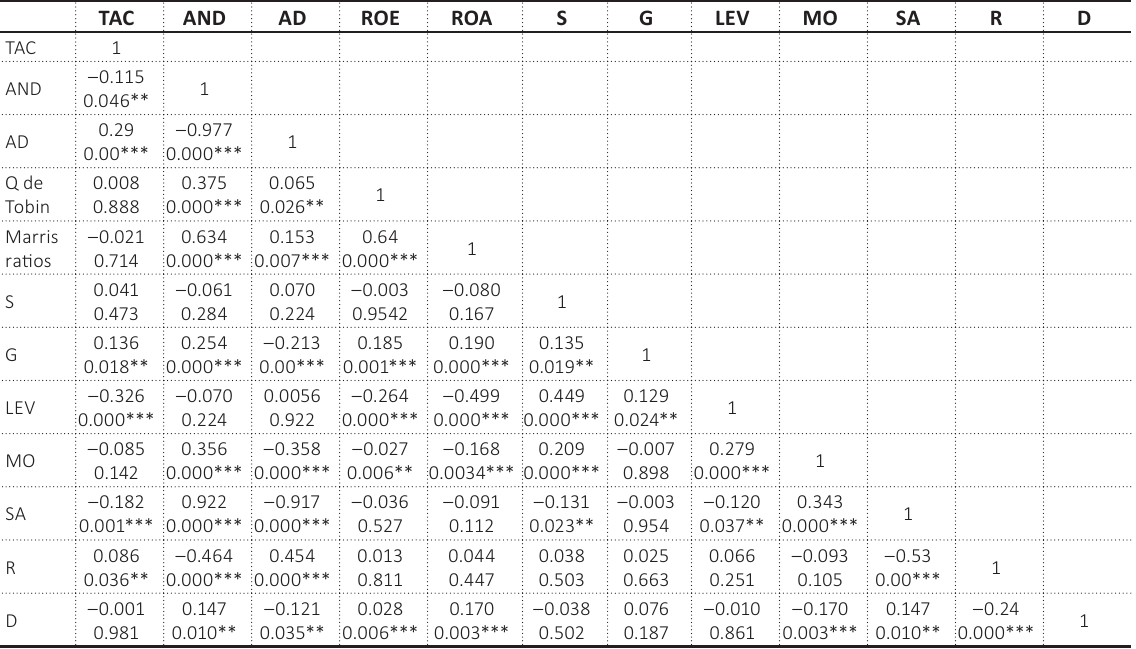
Table 2. Spearman